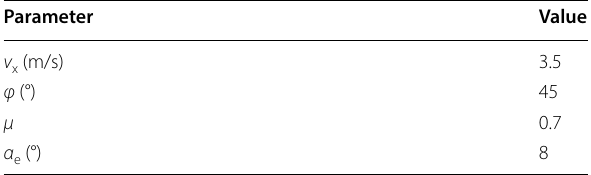
Table 5 Parameters of 2-2 condition